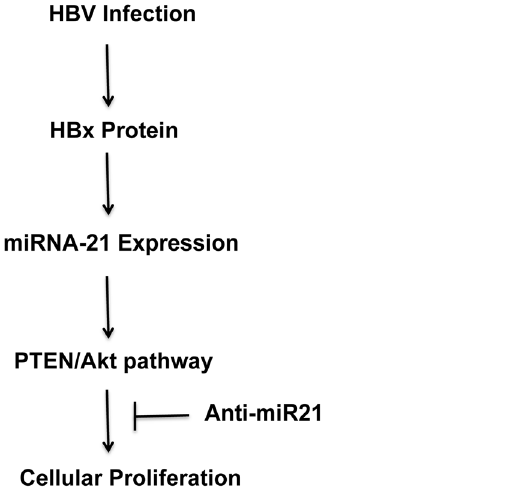
Figure 10. Proposed Model of HBx-miRNA-21 relationship. Schematic diagram showing the relationship between HBx, miRNA-21, akt and cellular proliferation in hepatic cells.